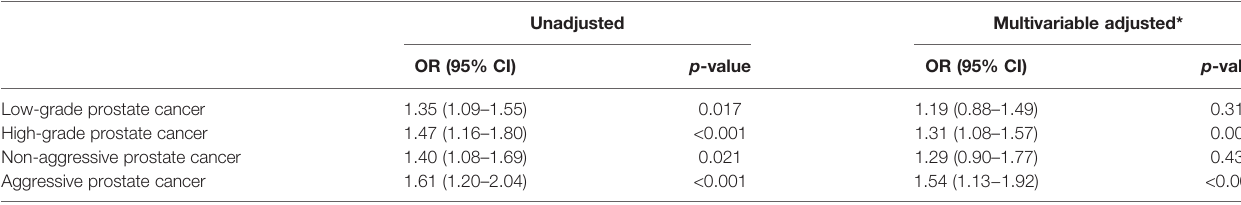
TABLE 2 | Association between marrow proton density fat fraction and prostate cancer